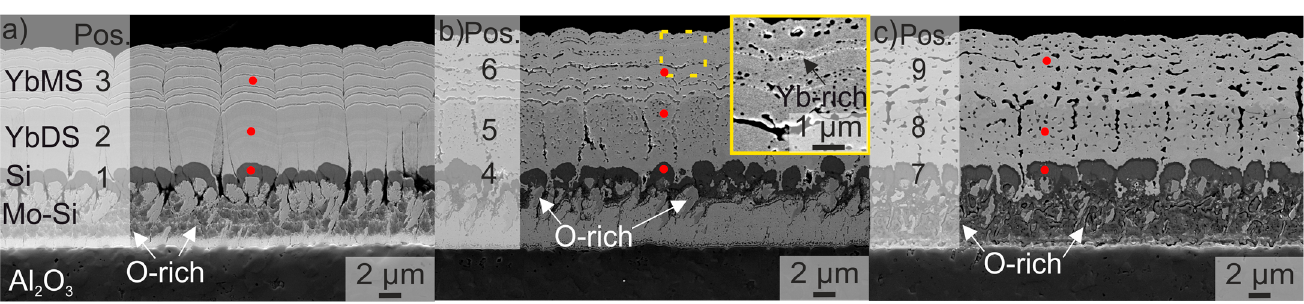
Figure 6. Secondary electron SEM micrographs of the dual-layer bond coat and the YbDS and YbMS EBC coatings on top of an Al 2 O 3 substrate; ( a ) after deposition in the as-coated state; ( b ) after crystallisation for 1 h at 900 ◦ C plus 1 h at 1200 ◦ C in air; ( c ) after additional 10 h of oxidation test at 1200 ◦ C with positions marked by red dots for different EDS spot analyses represented in Table 1. Table 1. EDS spot analyses in the marked red dots in Figure 6.